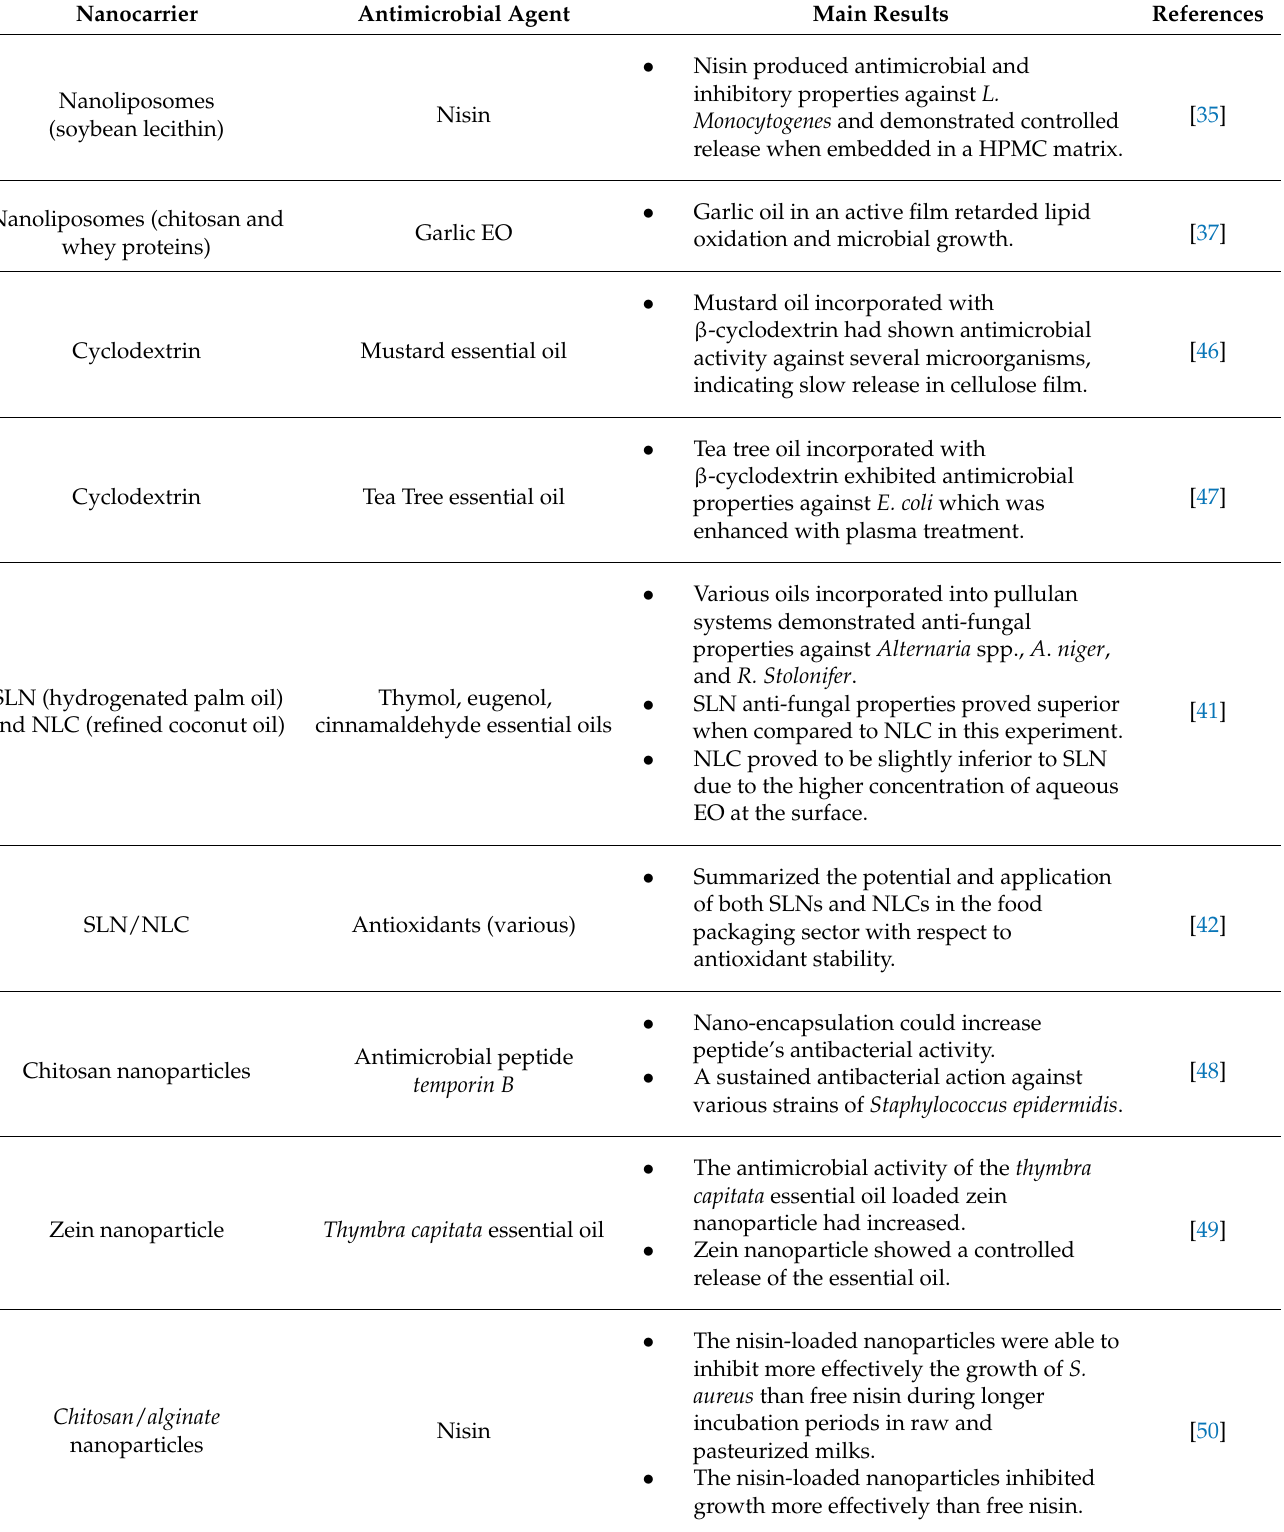
Table 1. Nanoencapsulation systems based on biopolymers for antimicrobial